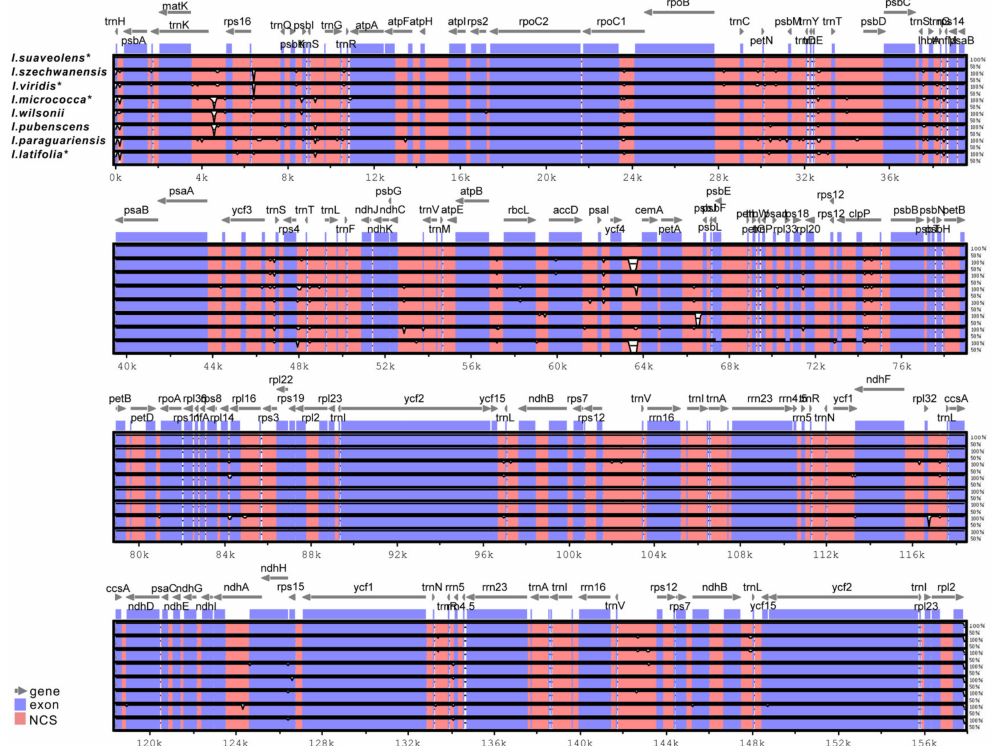
Figure 4. VISTA visualization of the alignment between the eight Ilex plastomes. The plots show the sequence identity with the I.suaveolens plastome, used as a reference. The vertical and horizontal axes represent the sequence consistency degree (50%–100%) and the sequence length, respectively. The locations of divergent hotspot regions are labeled along the top of the alignment, where the gray arrows indicate the orientation of the annotated genes. The red bars indicate the non-coding sequences (NCS), and white peaks represent di ff erences in chloroplast